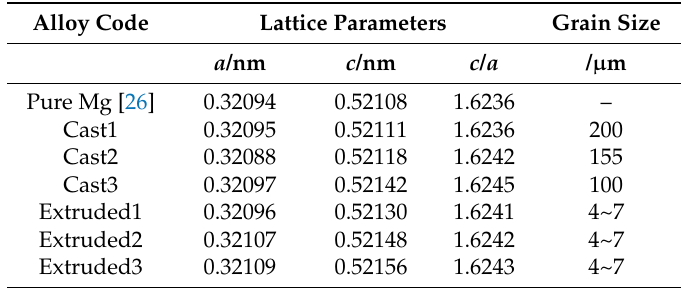
Table 3. Lattice parameters of α phase and mean grain size of Mg alloys.